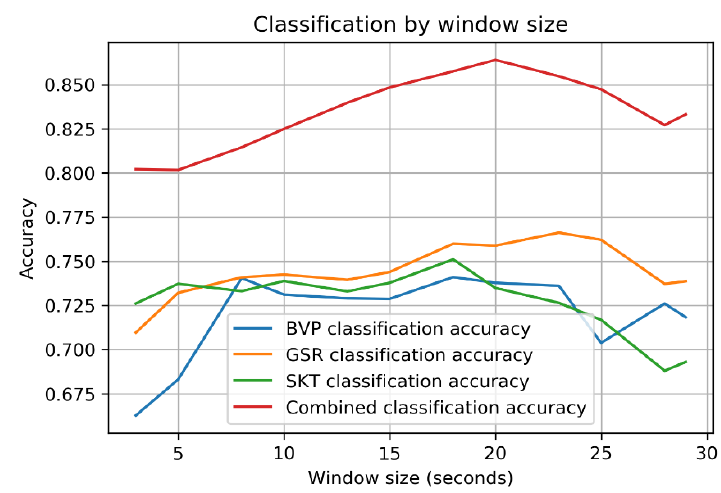
Figure 7. Anxiety level prediction using blood volume pressure (BVP), galvanic skin response (GSR), and skin temperature: accuracy dependency upon the length of the signal window.